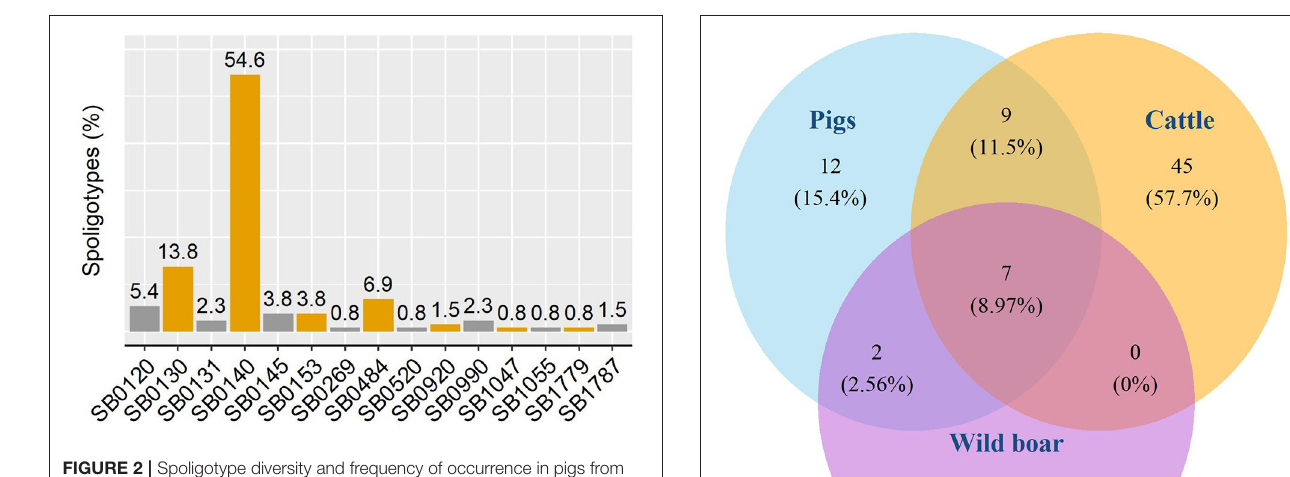
FIGURE 2 | Spoligotype diversity and frequency of occurrence in pigs from this study.